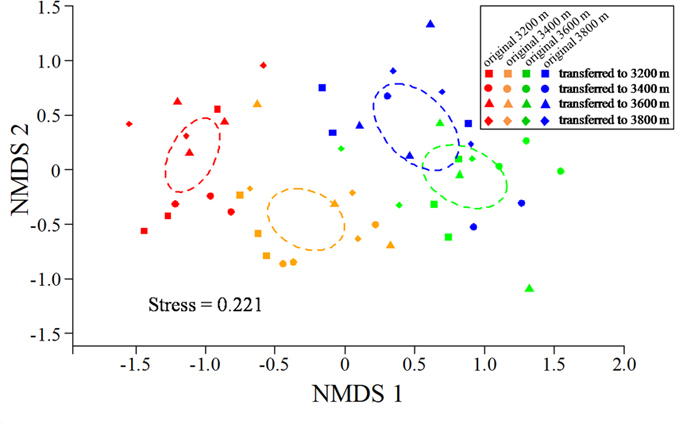
Non-metric multidimensional scaling (NMDS) of arbuscular mycorrhizal fungal community composition.Circles with dashed line in NMDS plot are 95% confidence ellipses of original elevations of 3200 m (red color), 3400 m (orange color), 3600 m (green color) and 3800 m (blue color).